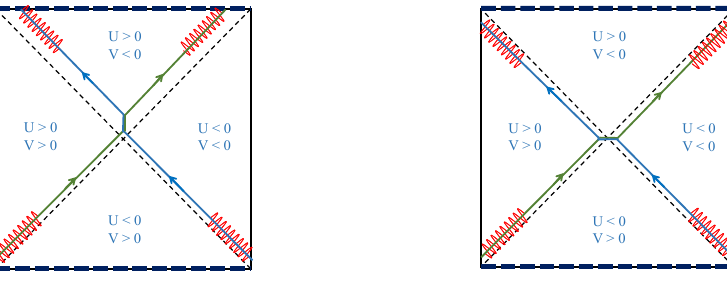
Figure 1 . The 2-to-2 shockwave scattering matrix has non-zero matrix elements between incoming and outgoing pairs of waves on either side of the black hole horizon. The interaction can produce a time delay (left) or a time advance (right). In the latter case, the particles traverse the wormhole. positive (or negative) Kruskal momentum. This is the standard construction of